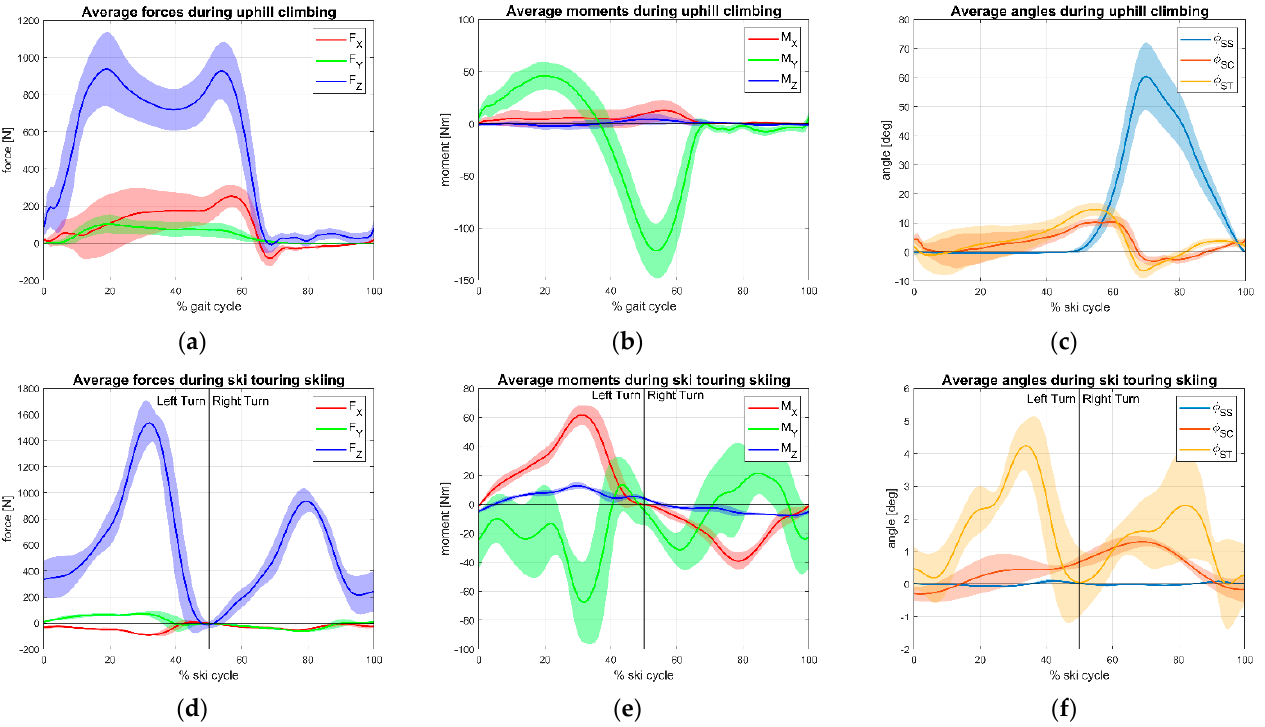
Figure 6. Ground reaction forces and kinematics during ski-touring session: ( a ) uphill forces; ( b ) uphill moments; ( c ) uphill angles; ( d ) downhill forces; ( e ) downhill moments; ( f ) downhill angles.